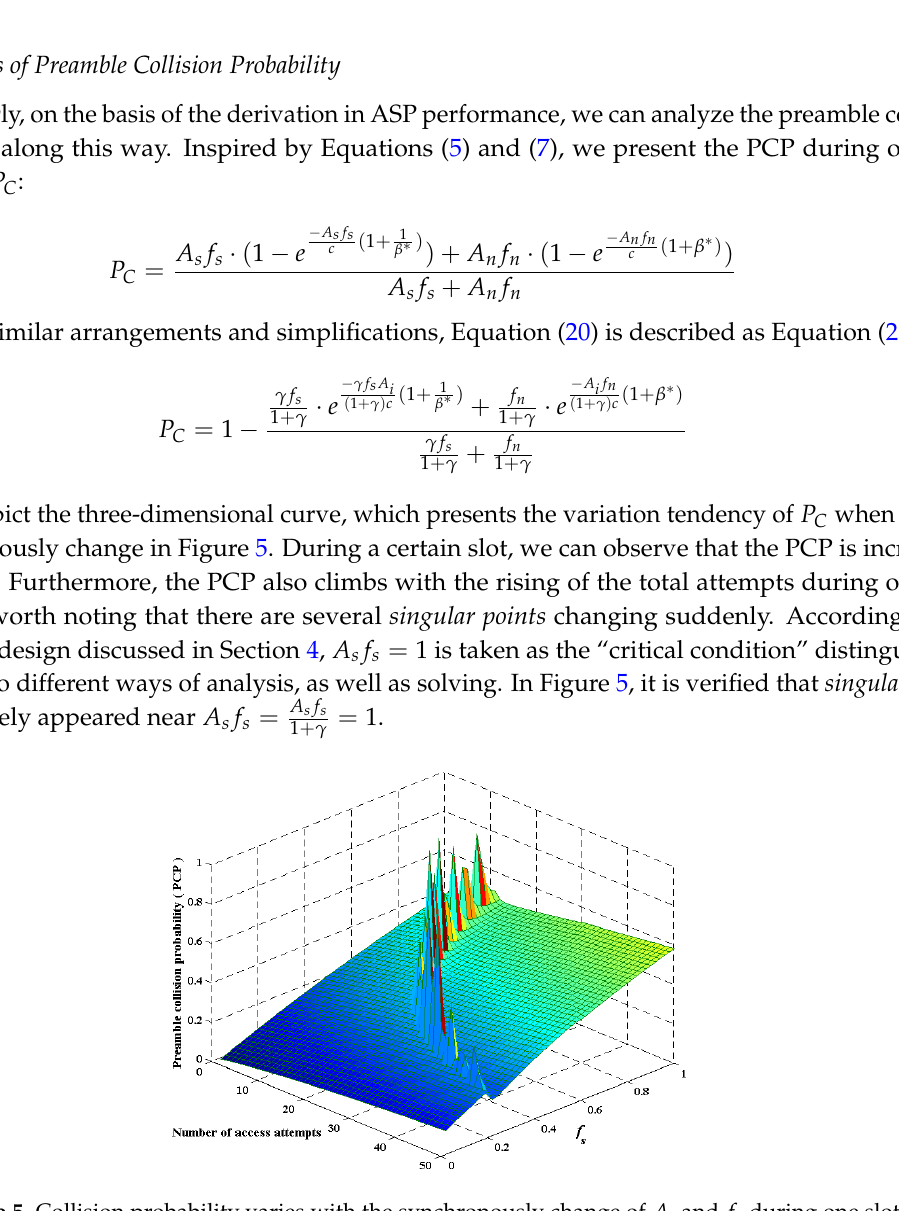
Figure 5. Collision probability varies with the synchronously change of A i and f s during one